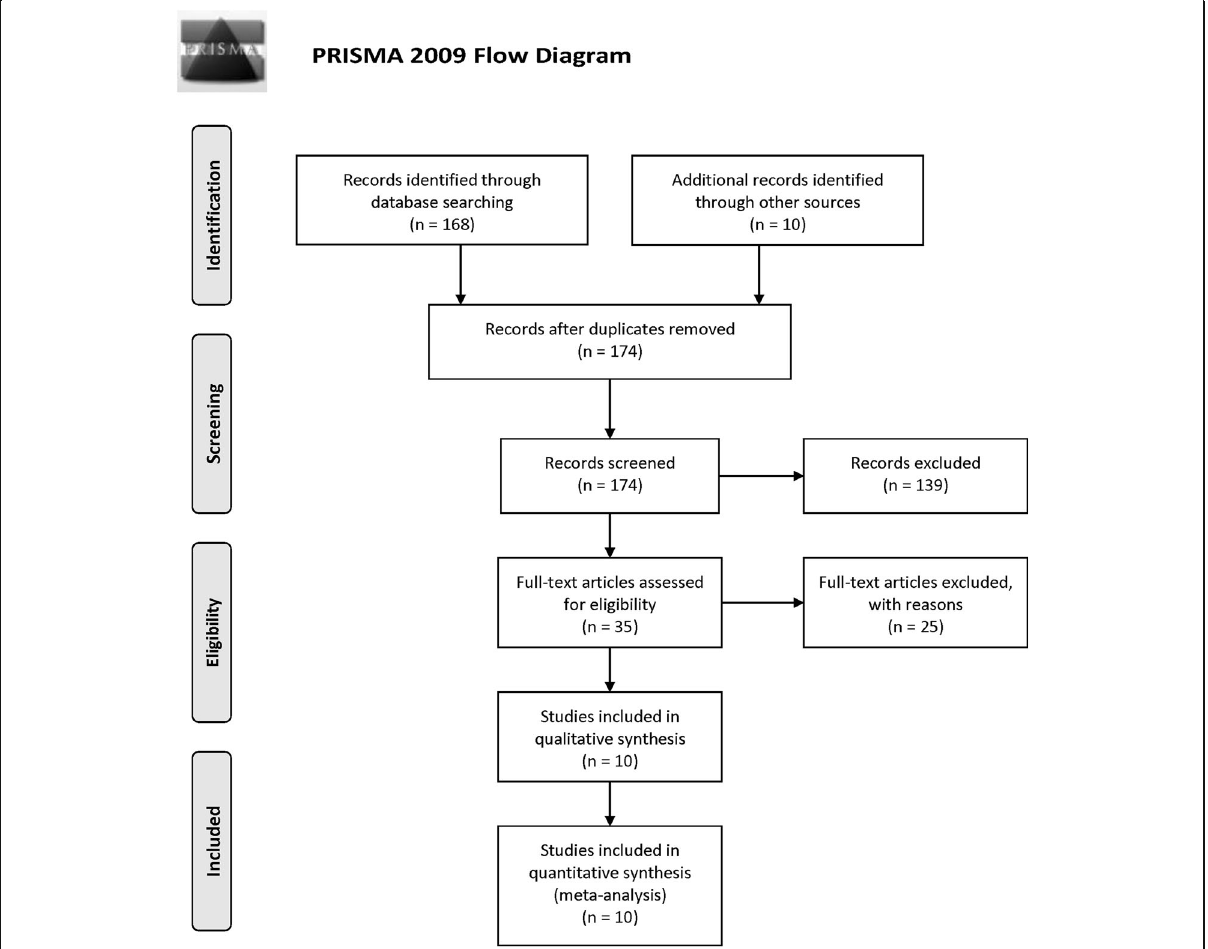
Fig. 1 PRISMA Flow-diagram depicting identification and selection process for the present